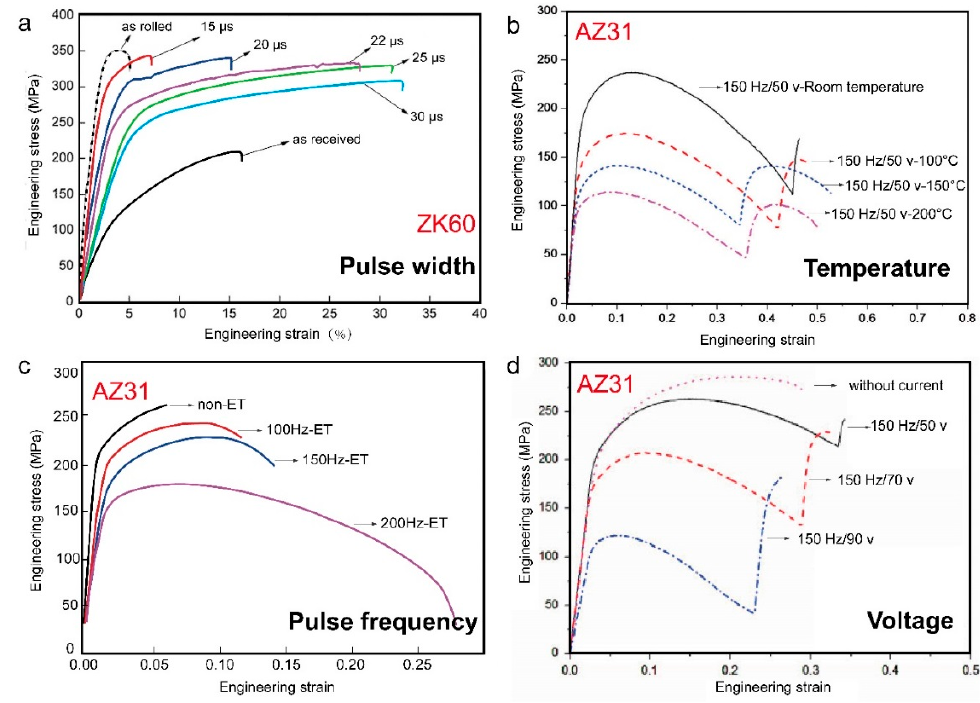
Figure 7. Stress-strain curves for magnesium alloys: ( a ) pulse width [67]; ( b ) temperature [89]; ( c ) pulse frequency [13]; and ( d ) voltage [114].